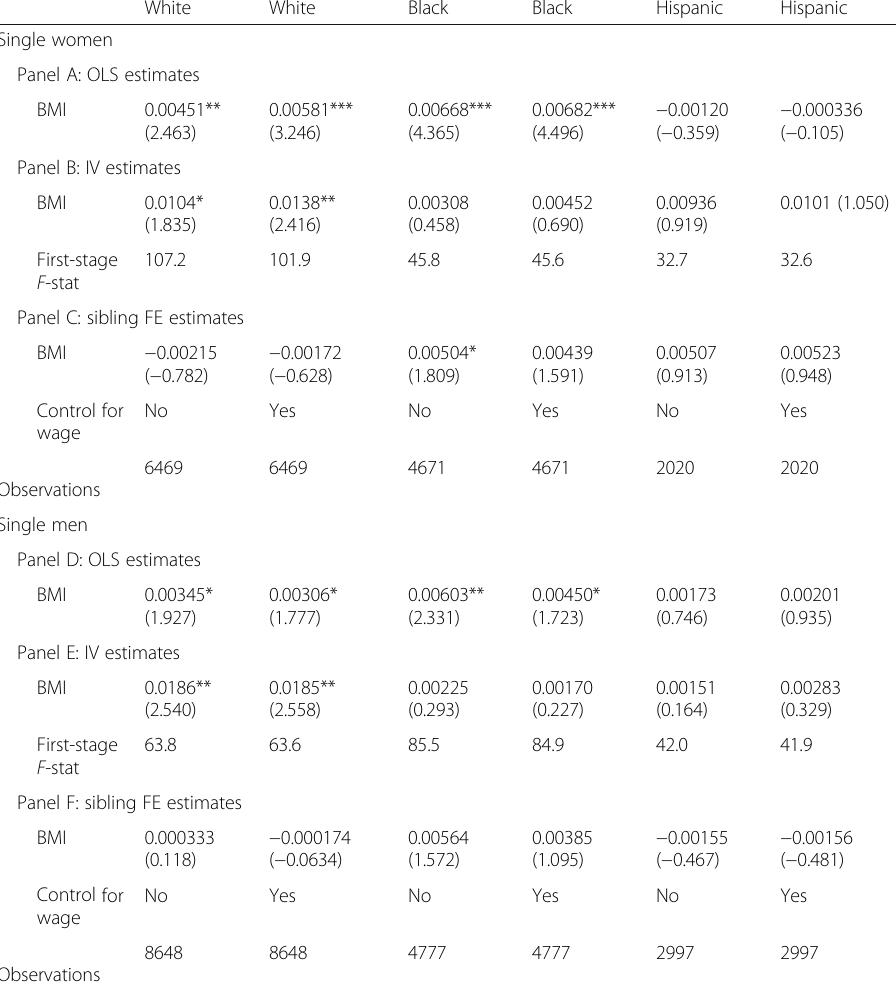
Table 3 BMI coefficients in log hours of work for single respondents: OLS, IV, and FE estimates White White Black Black Hispanic